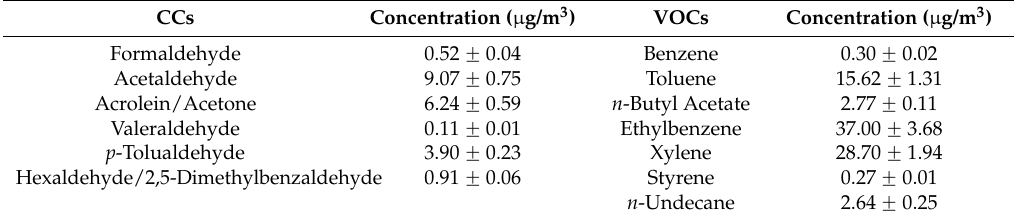
Average concentrations of target organic compounds in field blank sample during monitoring